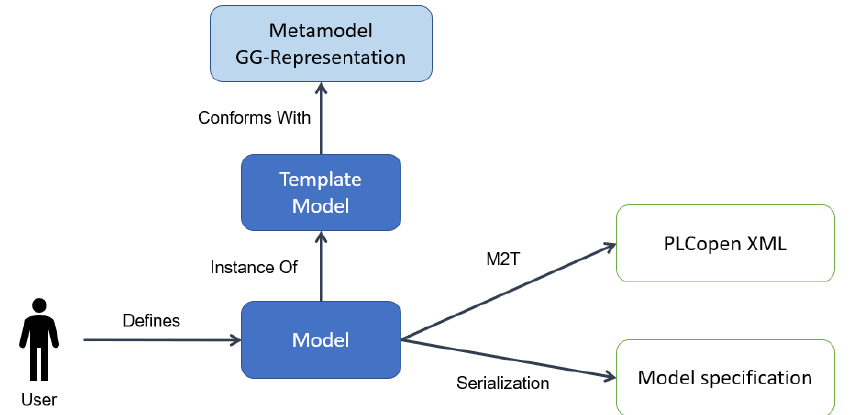
Figure 3. MDE transformation chain defined for the